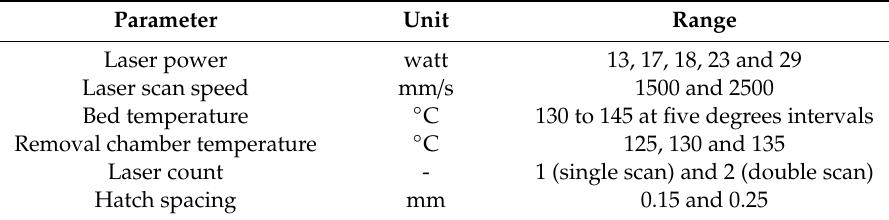
Table 5. Process parameters used in the initial trials of laser sintering of UHMWPE. Parameter Unit